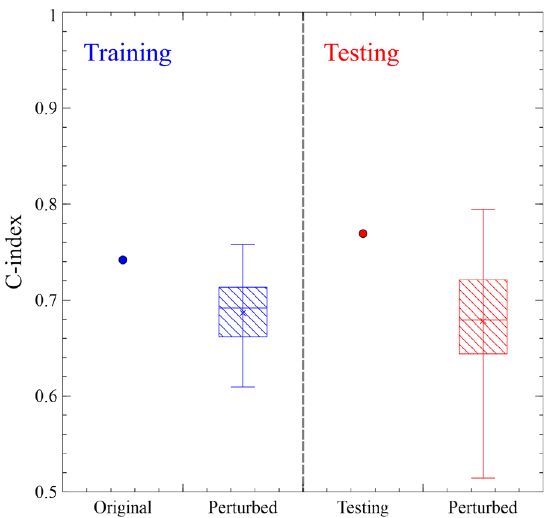
Figure 2. Visualization of model performance on the original and perturbed data.